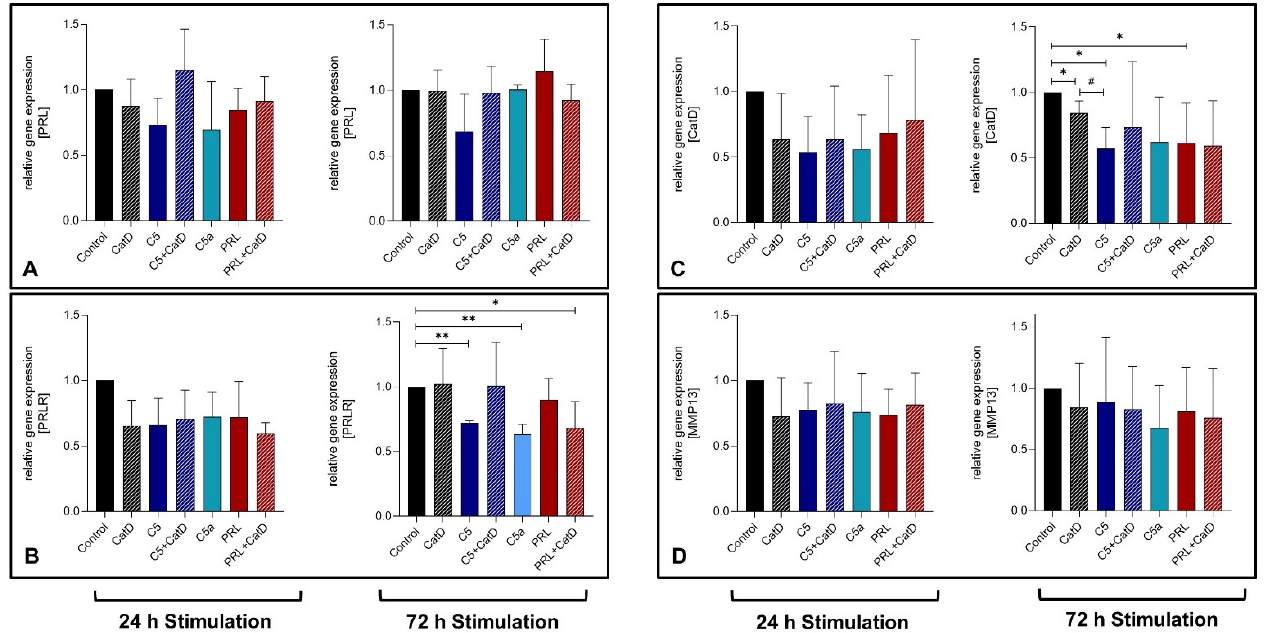
Figure 3. Graphic representation of relative chondrocytes gene expression of PRL ( A ), PRLR ( B ), CatD ( C ), and MMP-13 ( D ) after 24 h and 72 h of stimulation. n = 3 (24 h stimulation) and n = 5 (72 h stimulation) independent experiments with chondrocytes from different donors. Mean with standard deviation. Control has been normalized to 1. One sample t-test with significance in relation to control (*). Mixed-effects analysis using post-hoc Tukey’s multiple comparisons (#). */# = p ≤ 0.05, ** = p ≤ 0.01.